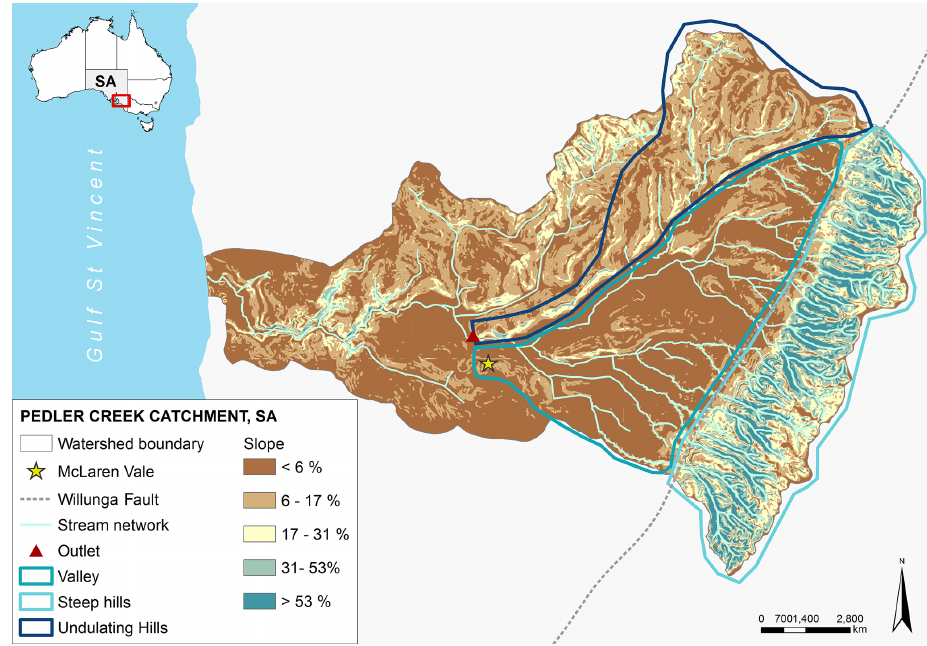
Figure 2. Pedler Creek catchment slopes highlighting the three distinctive areas for the sub-catchment area, namely undulating hills in the north, the steep hills to the east, and the low gradient